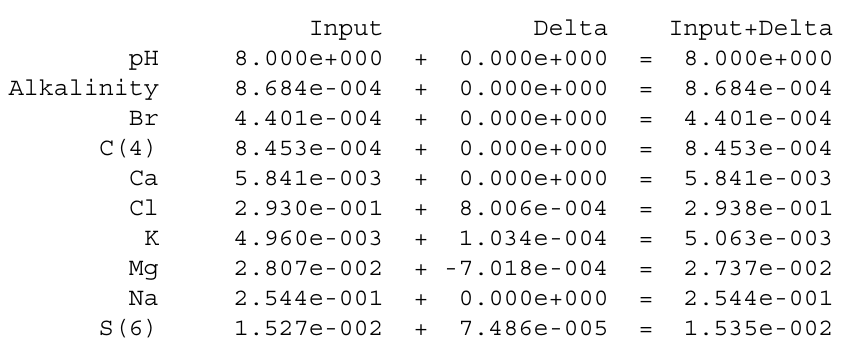
Table 50. Selected output for example 17. Solution 1: Black Sea